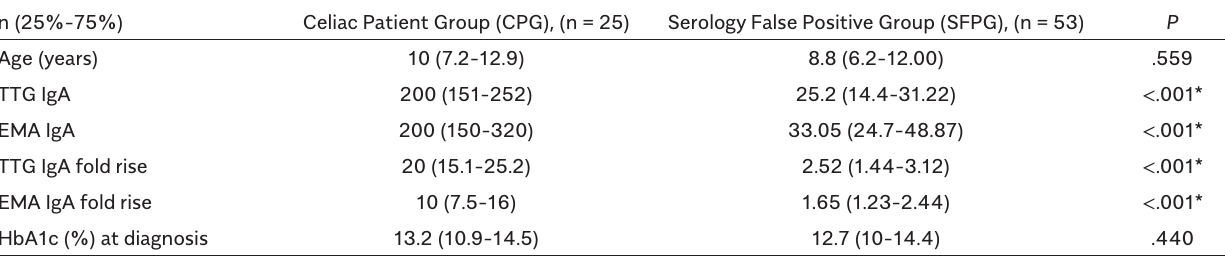
Table 3. Median Celiac Antibody Titers of the Subjects and Fold Rise in the Antibody Titers n (25%-75%)